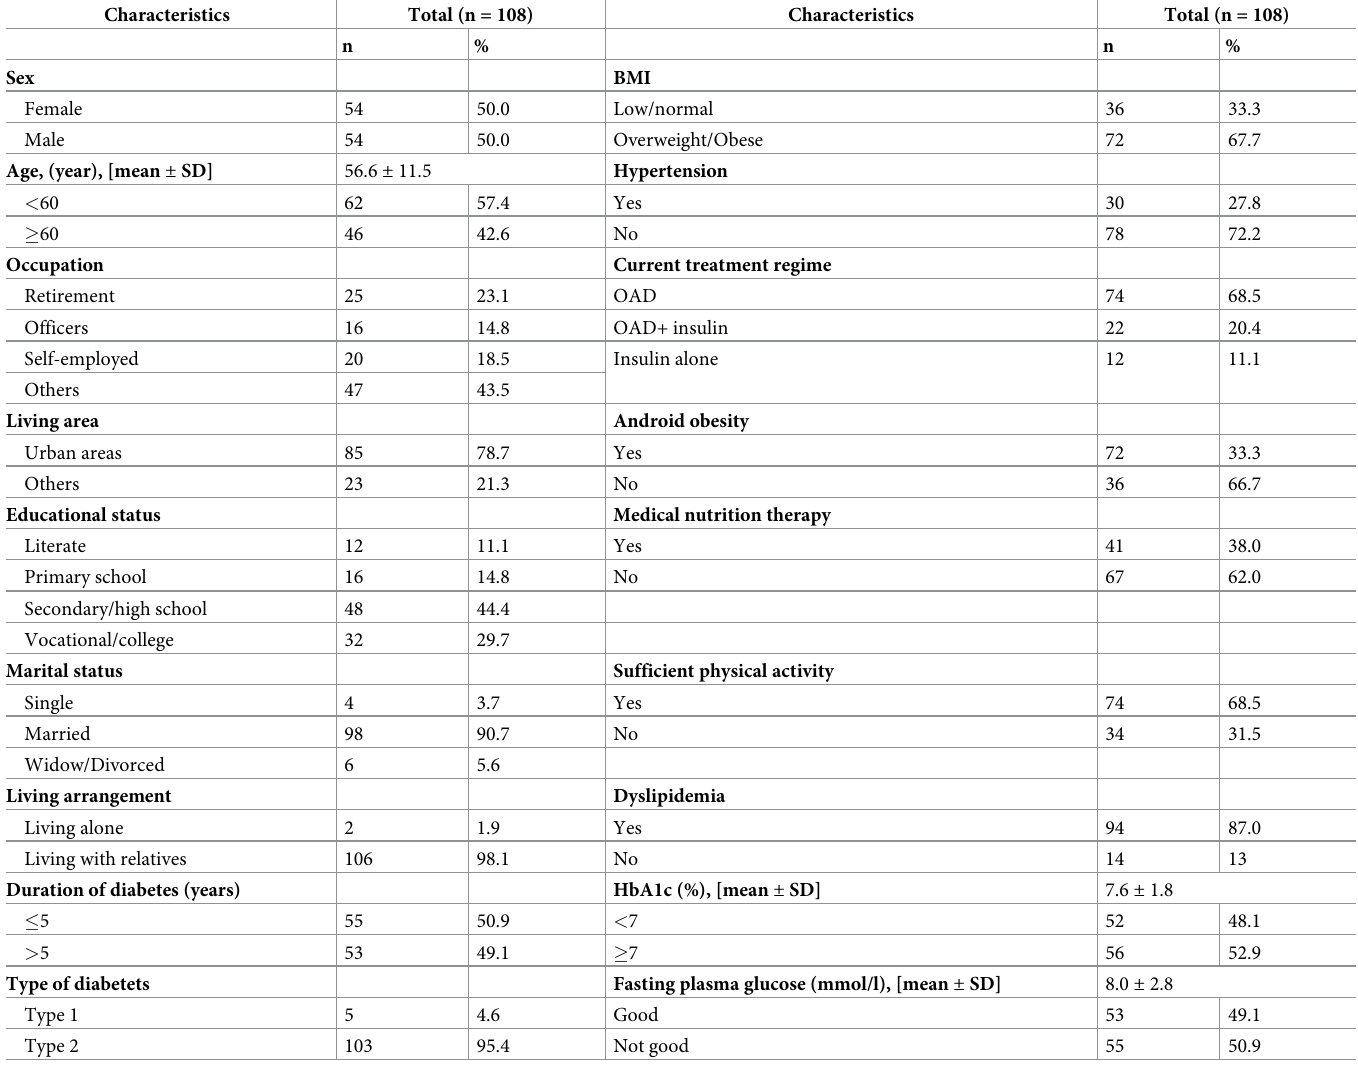
Table 1. Socio-demographic characteristics of DM